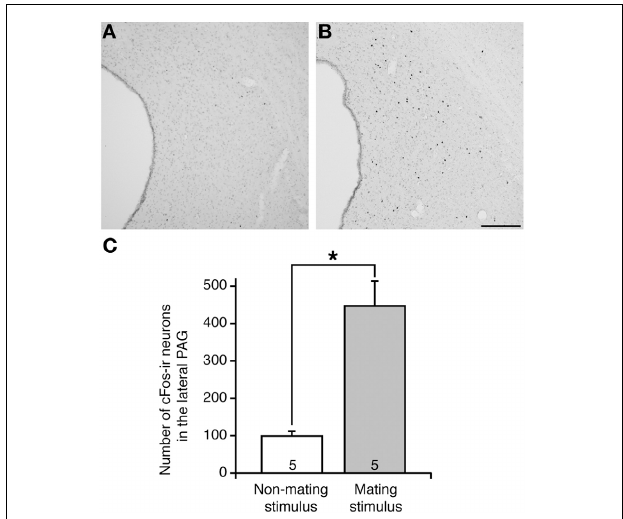
FIGURE 2 | (A) Coronal sections from the rat brain atlas of Paxinos and Watson (2006), showing the position of the MRF and representative photomicrographs showing the site of FG injection in the RF. (B) Representative photomicrographs of the caudal part of the lateral PAG in rat after injection of FG into the RF. High magnification of FG-ir (brown) and cFos-ir (black) neurons in the caudal part of the lateral PAG in a non-stimulated control rat (C) and a mating-stimulated rat (D) . Arrows show FG-ir neurons with cFos-ir in nuclei. Scale bar: 200 μ